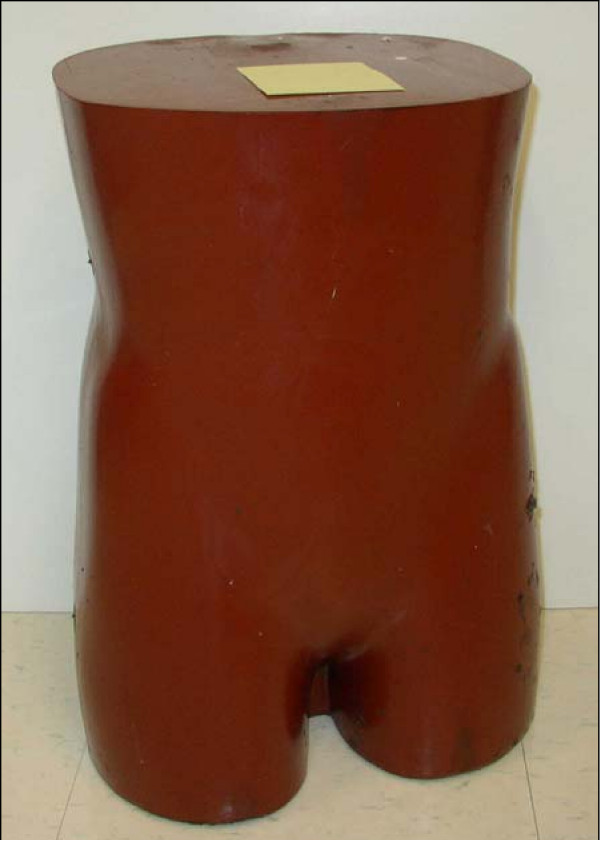
Humanoid abdominal/pelvic phantom.